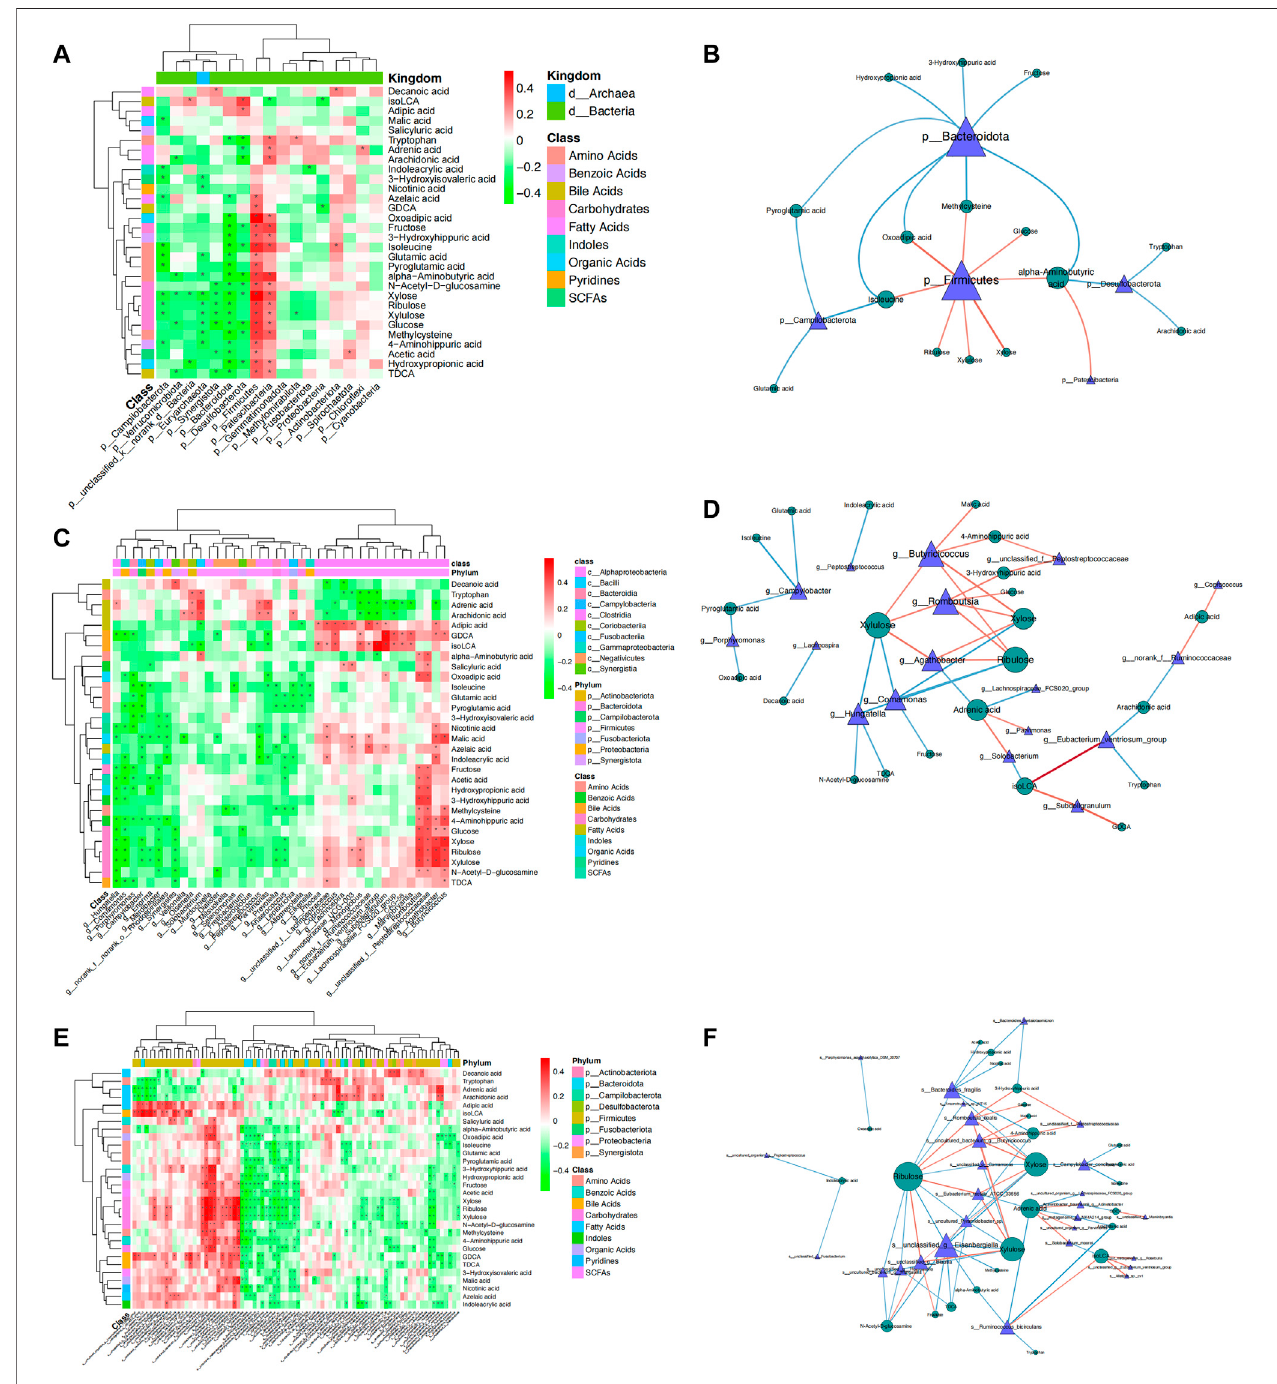
FIGURE 5 | Spearman ’ s rank correlation between metabolites and gut microbiota in CRC and NC groups. A network diagram and heatmap demonstrating the correlation between differential metabolites and bacteria at the phylum, genus, and species levels. Spearman rank correlation coef fi cient, *: p < 0.05. Red represents a positive correlation, while blue and green represent a negative